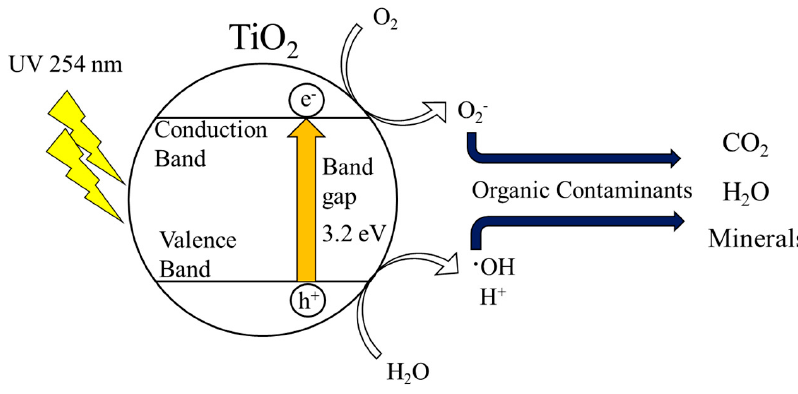
Figure 3. Schematic diagram of the photolysis Mechanism of TiO 2 .